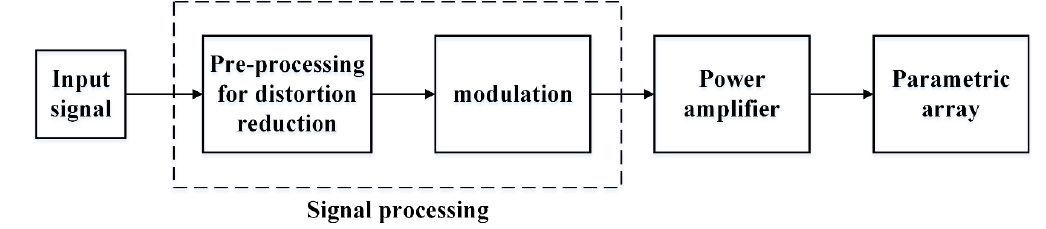
Figure 4. Block diagram of the PAA system.